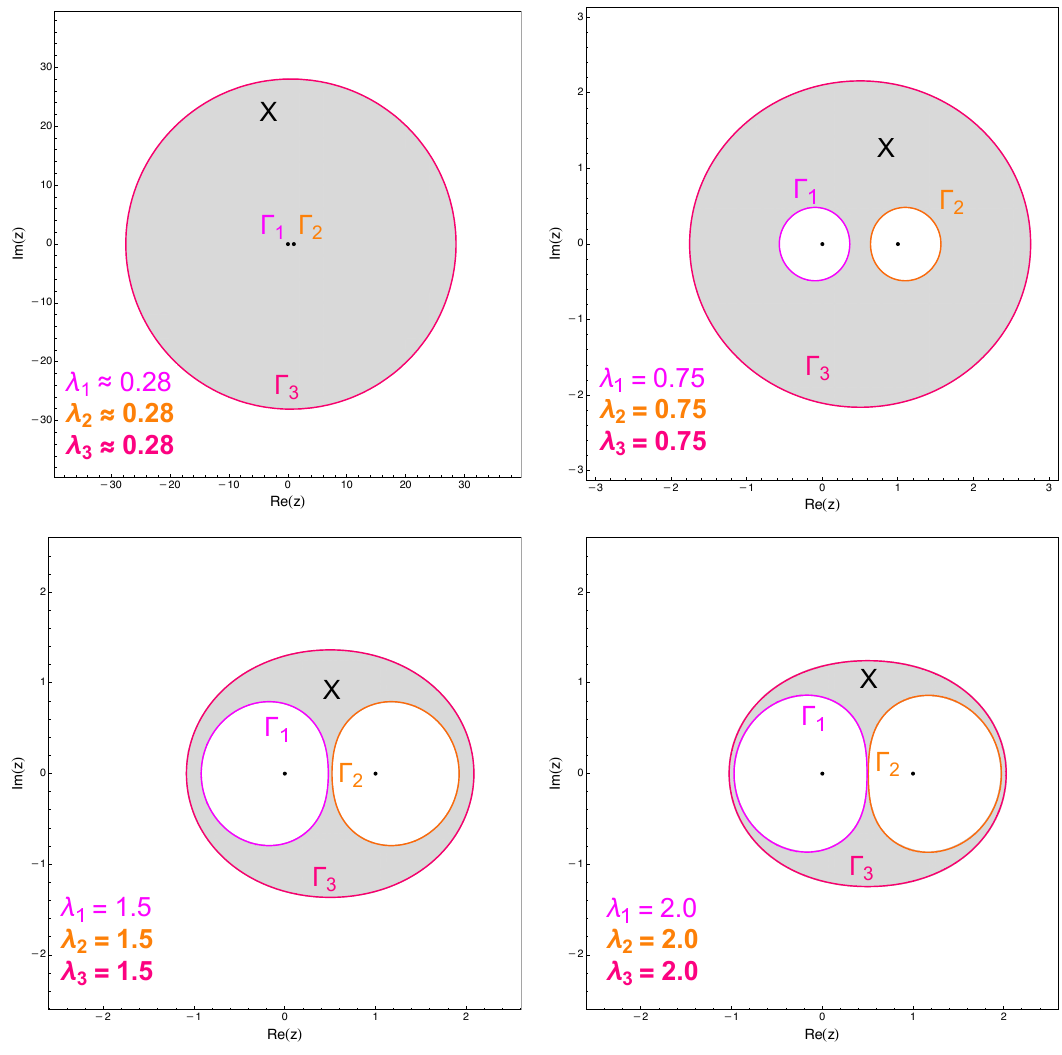
Figure 6 . Four examples for the pants diagram region X on the z -plane in the case of equal geodesic radii. Punctures are located at z = 0 , 1 , ∞ , and indicated by black dots. We only show the most-distant separating geodesics Γ j because we performed a surgery and take out everything surrounded by them. The region remaining X is endowed with the hyperbolic metric (3.24) and Γ j are its geodesics by construction. Note that the geodesics Γ 1 and Γ 2 in the critical case λ = arcsinh(1) /π ≈ 0 . 28 are so small that they haven’t rendered in the top-left figure. which describes a flat semi-infinite cylinder ( K = 0 ) of radius λ j